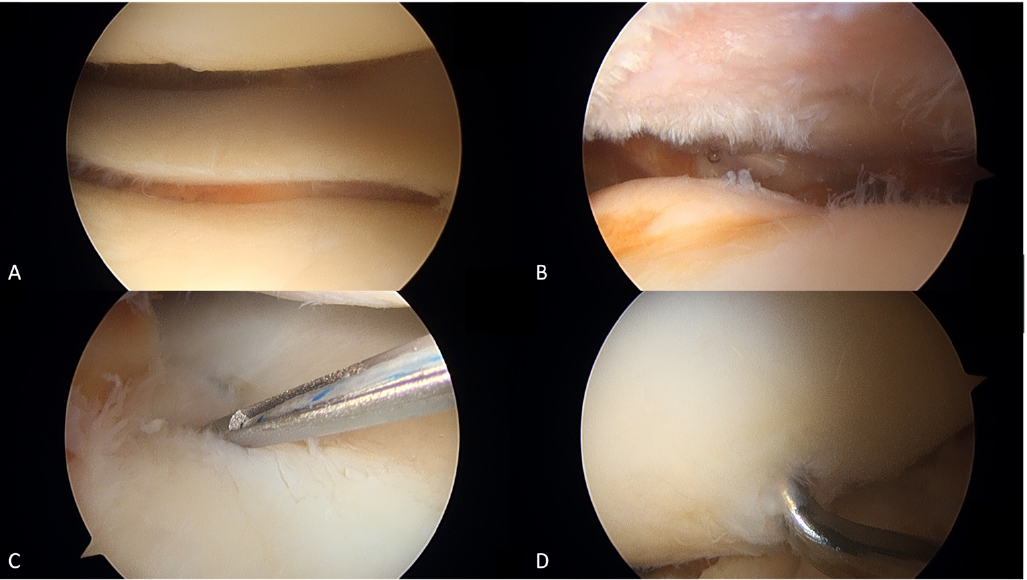
Figure 3. Arthroscopic image: ( A ) intact medial meniscus and good quality of cartilage, ( B ) lateral meniscus tear and lateral compartment OA change, Outerbridge grade 4, ( C ) lateral meniscus repair with all-inside technique, ( D ) microfracture of femoral condyle.